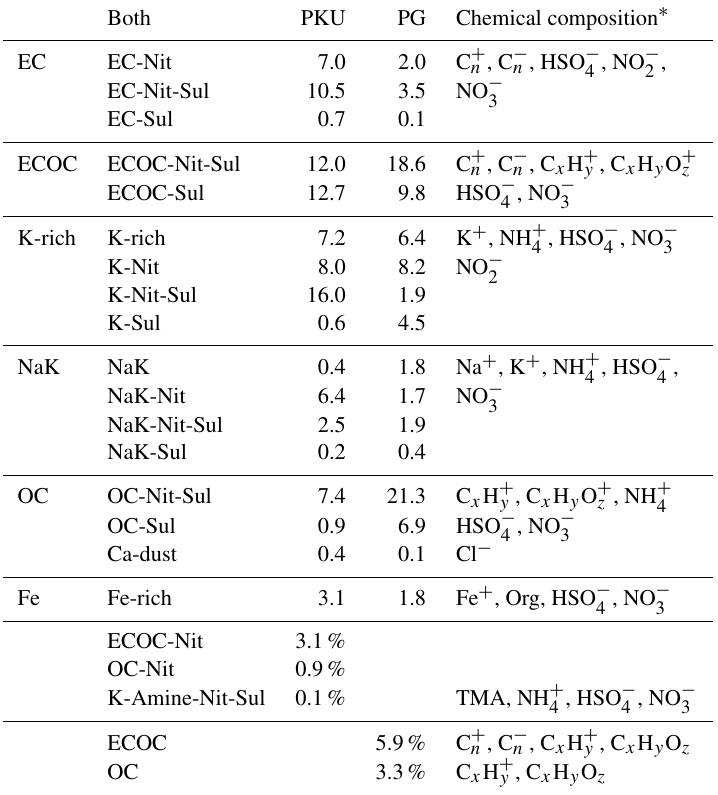
Table 1. Particle types and their relative fractions and chemical composition.